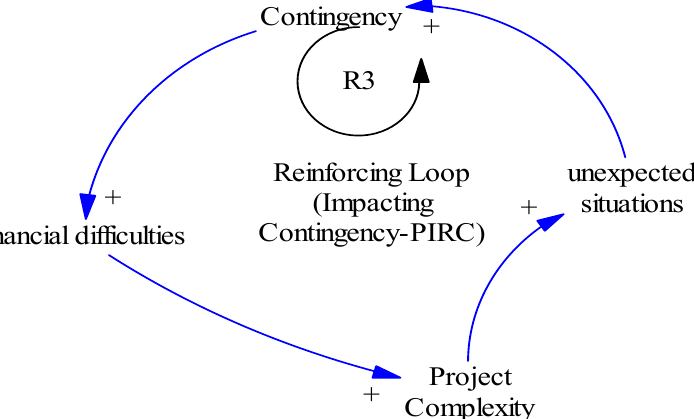
Figure 5. Impact on profitability risk category–contingency (reinforcing loop-R3).